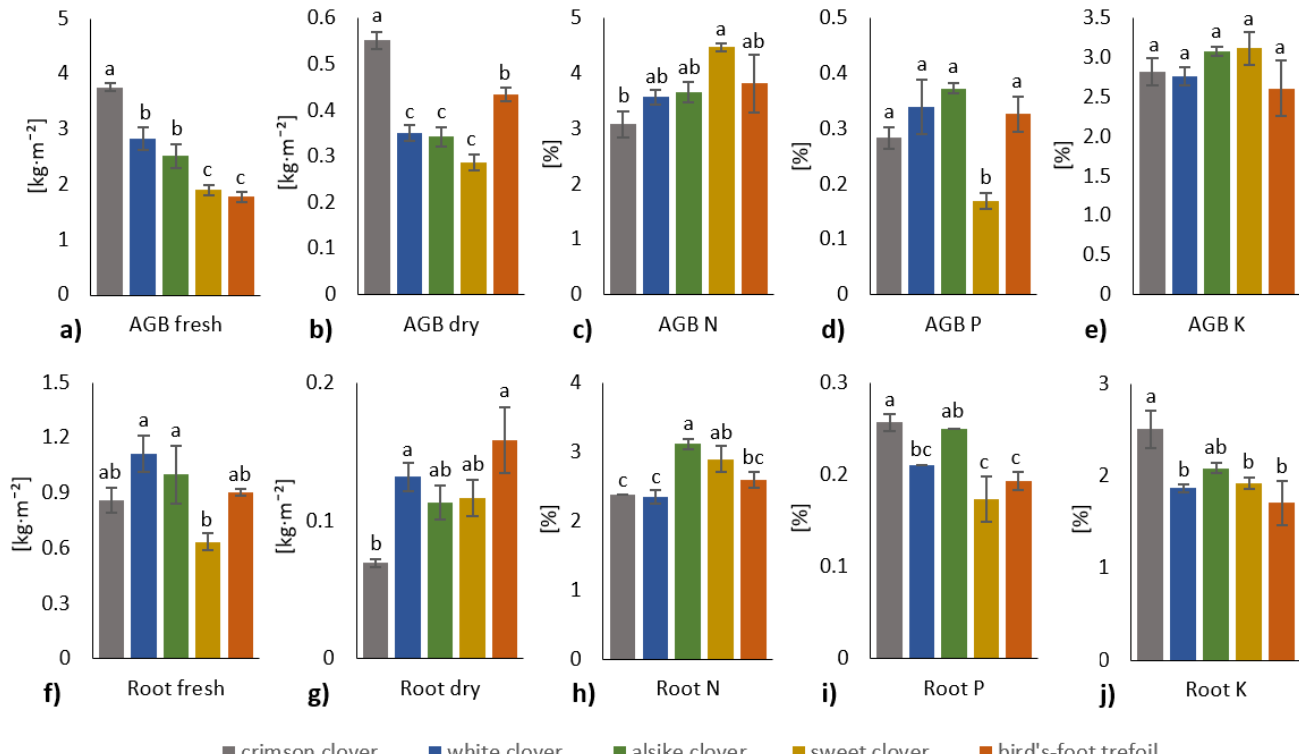
Figure 3. Plant ( a ) fresh and ( b ) dry aboveground biomass (AGB), ( f ) fresh and ( g ) dry root biomass, and ( c – e , h – j ) biomass nutrient (N,P,K) content in dry plant biomass of experimental variants = various types of clover/legume crops harvested after plant growth period 76 days. Values are displayed in kg·m − 2 (AGB and root biomass) and weight per cents (% w / w ), calculated as average from independent replicates (n = 3), error bars represent standard deviation. The different letters express the statistical differences at significance level p ≤ 0.05.